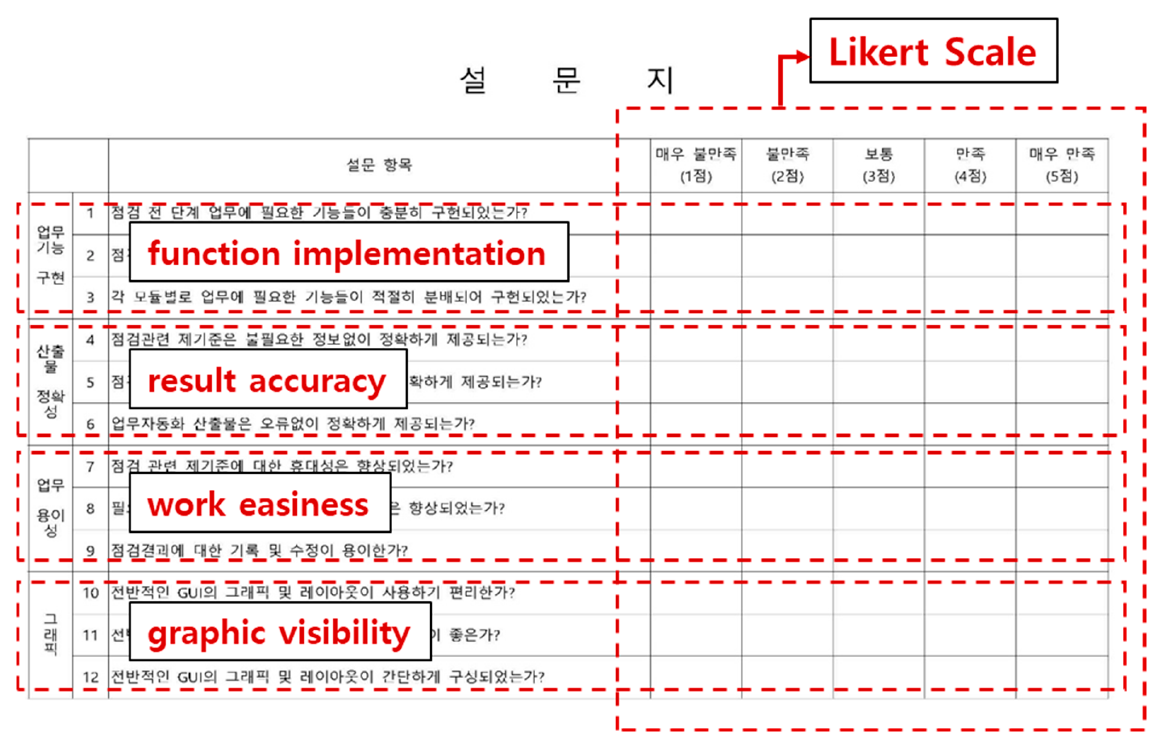
Figure 19. Questionnaire for the system convenience assessment.